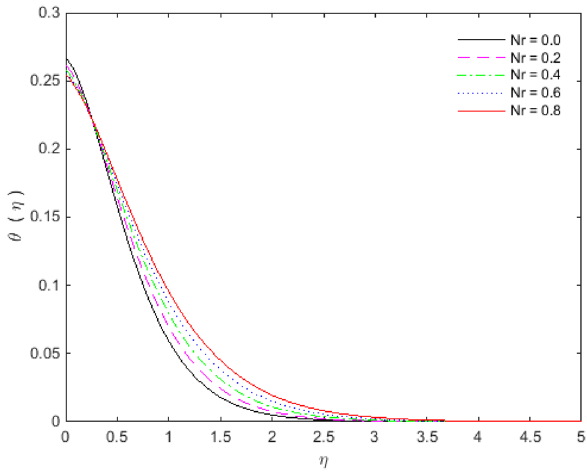
Figure 14. Temperature profile for Nr .